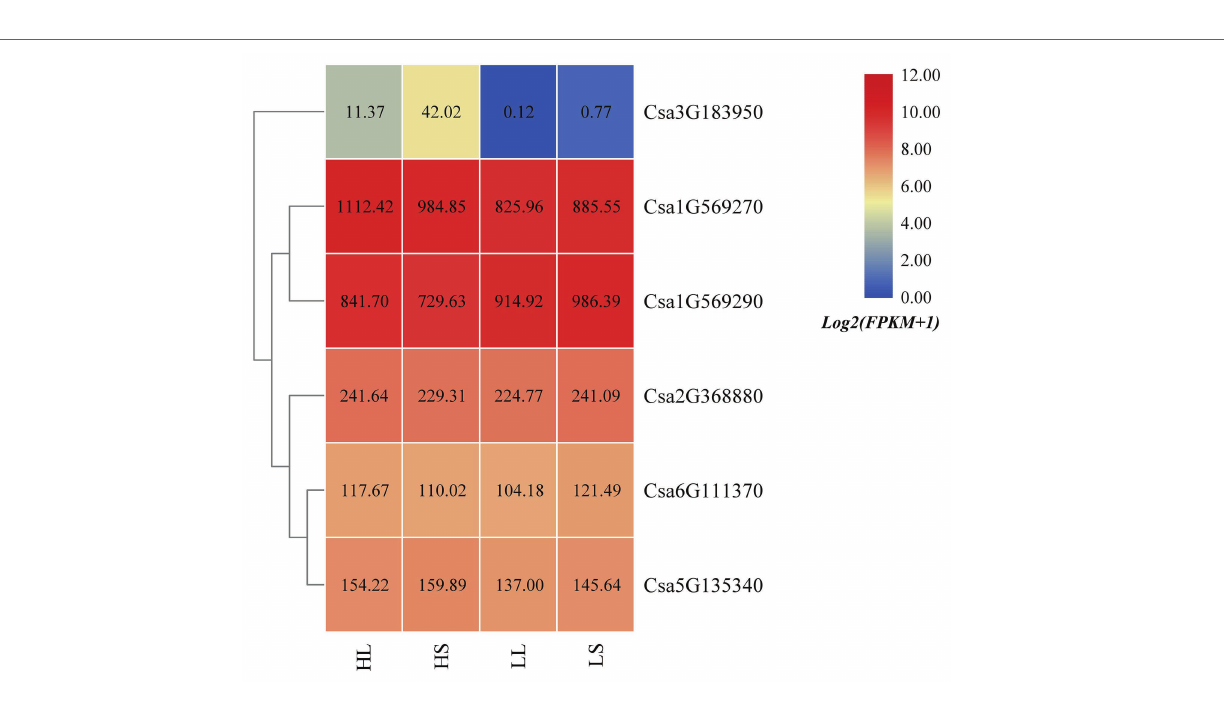
FIGURE 7 | The expression heatmap of the cucumber HSP90 gene family under temperature and photoperiod treatment. HL is high temperature and long day; HS is high temperature and short day; LL is low temperature and long day; LS is low temperature and short day. The data in the boxes indicate original FPKM